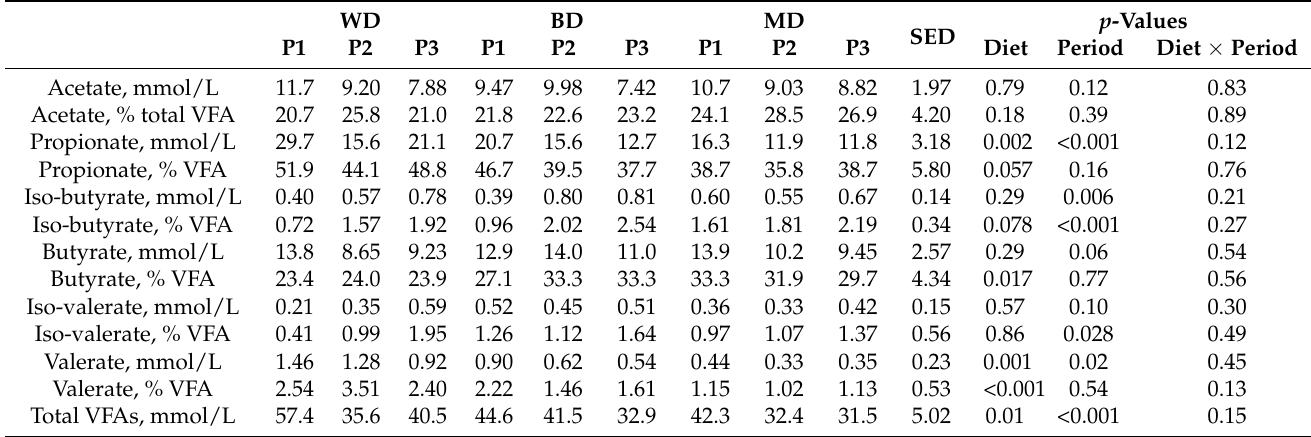
Table 4. Dietary effect on the rumen volatile fatty acids (VFAs) of Merino lambs subjected to 3 different feeding period levels and environmental conditions 1